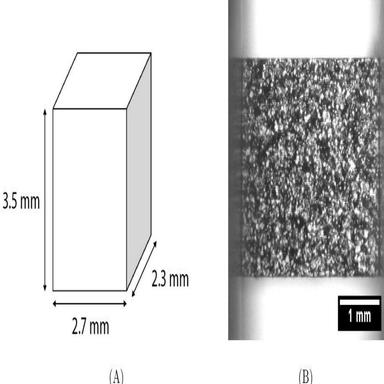
A) AD85 alumina sample dimensions with hot pressing direction along the long edge. B) Speckled sample under dynamic compression experiment lighting taken using the Shimadzu HPV-X2.